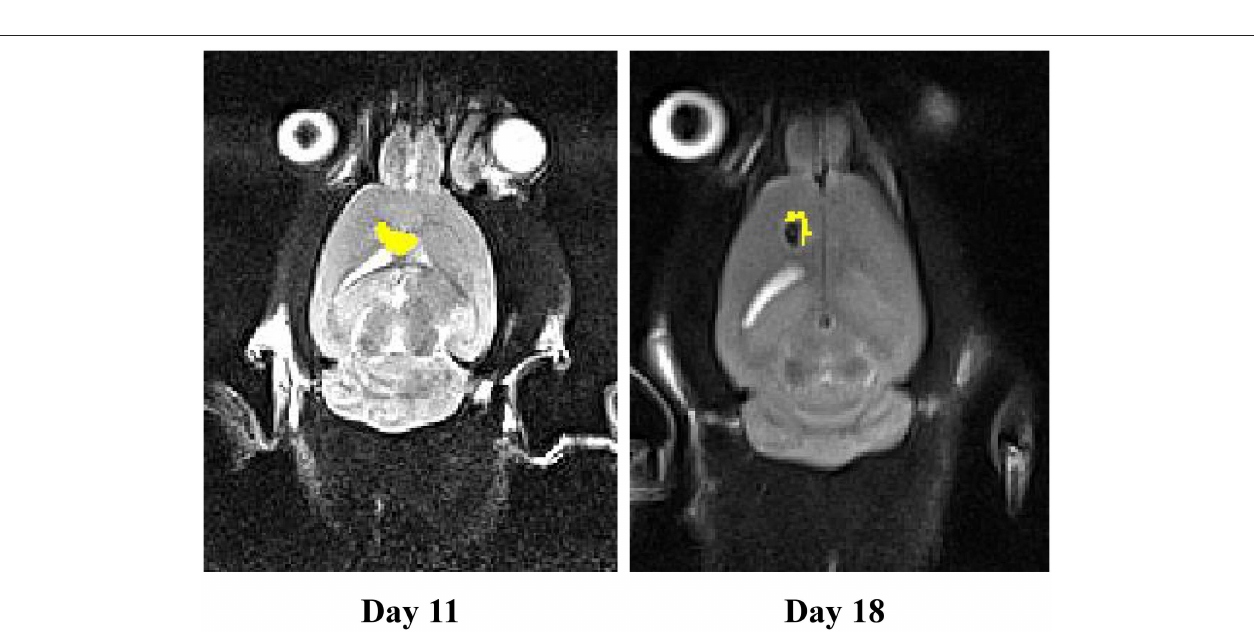
FIGURE 8 | The MRI results on a rat model of glioblastoma treated with fresh exosomes containing miR-21-sponge. Results from the third repeat treated with freshly prepared exosomes containing miR-21-sponge demonstrated good effects not only in inhibiting tumor growth, but also in eradicating tumor mass. Note the black area in the middle of the treated tumor on day